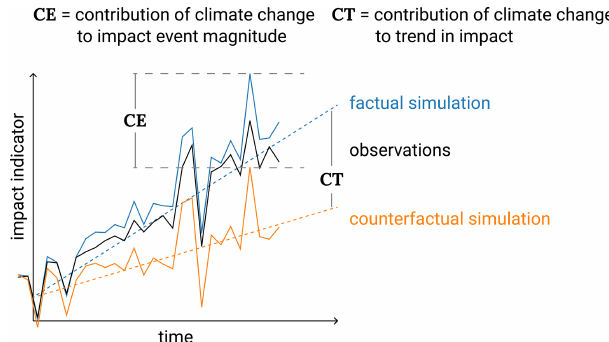
Figure 2. Attribution of impact event magnitude and trends in im- pact indicators to trend in climate. First, in an evaluation step it has to be demonstrated that historical impact observations (black line) can be explained by the process understanding as represented in the applied impact model and available knowledge about his- torical climate and socio-economic forcings. To this end, the fac- tual simulations forced by historical climate and socio-economic forcings (solid blue line) are compared to the impact observations (solid black line). Secondly, in the attribution step the impact model is driven by counterfactual climate while all other drivers are kept equal to the factual simulation (counterfactual simulation; solid or- ange line). A comparison between factual and counterfactual simu- lations allows for the attribution of long-term changes (e.g., trends) in the impact indicator to trends in climate (contribution to trend, CT). In addition, the contribution of climate change to the magni- tude of individual events (impact event attribution) can be deter- mined as the difference between the simulated factual event magni- tude and the counterfactual impact event magnitude